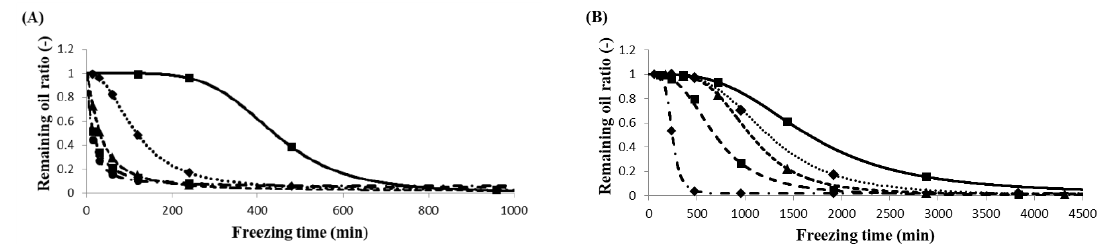
Figure 1. The stability of mayonnaise showing remaining oil ratio versus time after fitting the data. ( A ) RoM (rapeseed oil mayonnaise); and ( B ) SoM (soybean oil mayonnaise) for freezing at temperatures of –20 °C ( ), –25 °C ( ), –30 °C ( ), –35 °C ( ), and – 40 °C ( ). Points on the fitted curves indicate the experimental data. Results are expressed as the mean of four trials. Table 3. Induction time of oil separation for RoM and SoM.